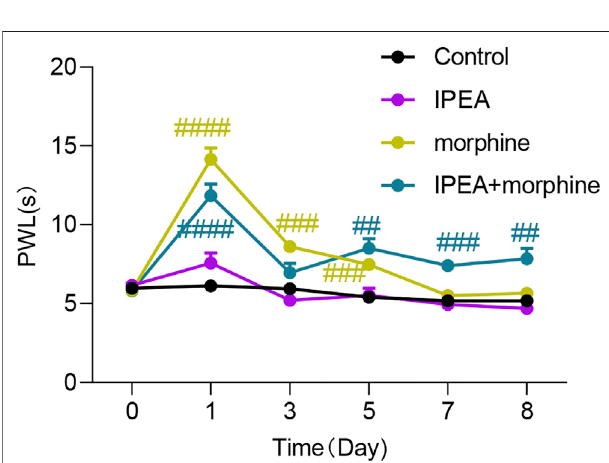
FIGURE 3 | Co-administration of IPEA with morphine improves morphine tolerance. Mice were pretreated with intraperitoneal IPEA (5 mg/kg) for30 min,followedby5 mg/kgmorphineadministrationforeightconsecutive days. PWL were measured 30 min after morphine injection on day 1, 3, 5, 7and 8.Two-way ANOVA revealedsigni fi cantdrug effects (F3, 37 (cid:2) 58.37, p < 0.0001) and time effects (F3.362, 123.1 (cid:2) 53.92, p < 0.0001) followed by Dunnett post hoc test. Data were presented as the mean ± SEM ( n (cid:2) 8 – 12 mice per group. # p < 0.05, ## p < 0.01, #### p < 0.0001 vs control.